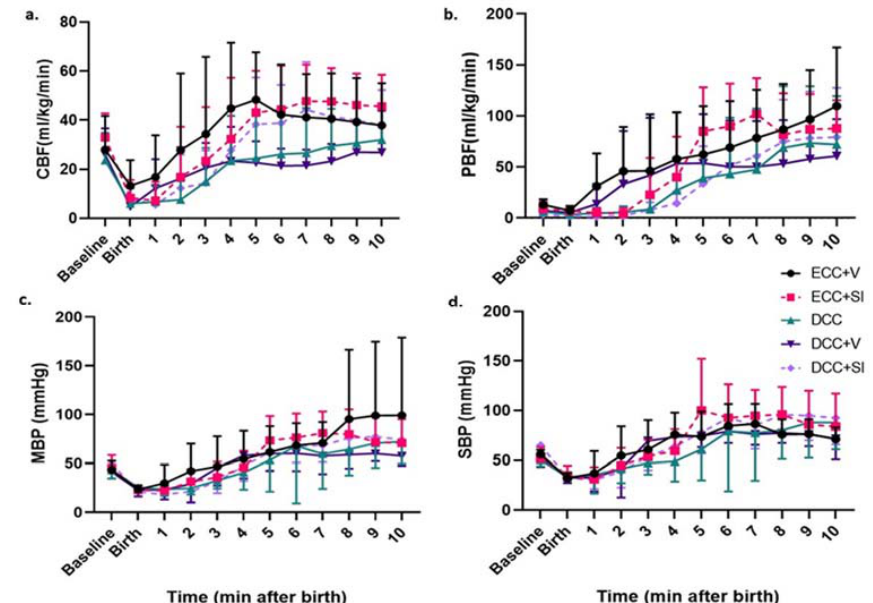
Figure 2. Post resuscitation hemodynamics in the first 10 min after birth in the five study groups: ( a ) carotid blood flow, ( b ) pulmonary blood flow, ( c ) mean blood pressure and ( d ) systolic blood pressure in all five study groups, with dashed lines reflecting the SI groups. Data are represented as mean ± SD. Black circle: ECC + V ( n = 5), pink square dashed: ECC + SI ( n = 6), green triangle: DCC ( n = 5), purple triangle: DCC + V ( n = 5), purple diamond dashed: DCC + SI ( n = 7).